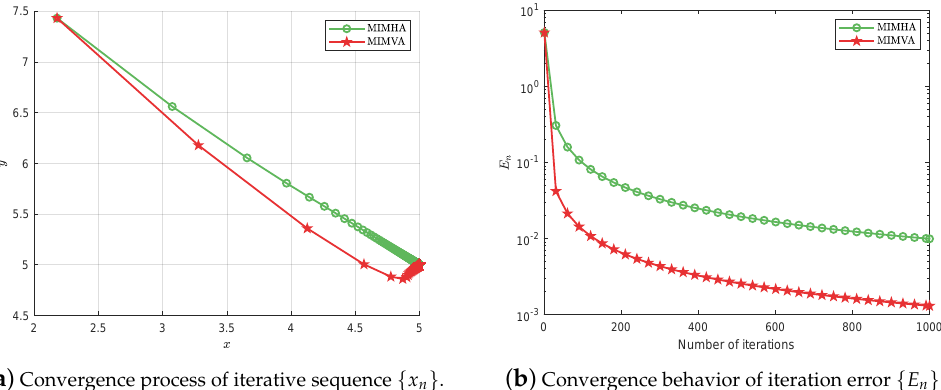
Figure 4. Convergence behavior of { x n } and { E n } for Example